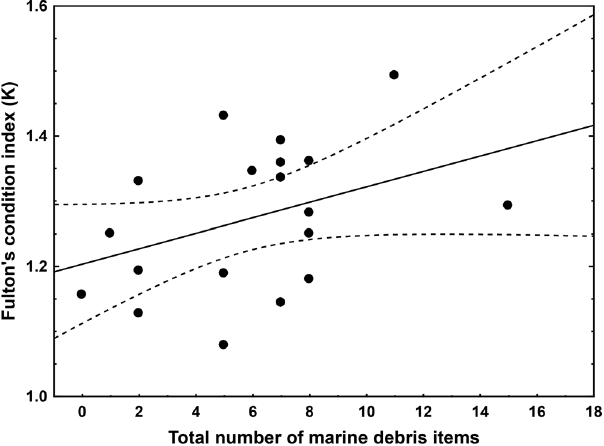
Figure 4. Condition of juvenile coral trout. The condition (Fulton’s condition index, K) of individual juvenile coral trout ( Plectropomus leopardus and P. maculatus ) plotted against the total number of marine microdebris items detected in each of the 20 gastrointestinal tract. Fish were collected on reefs around four reef islands in the Great Barrier Reef World Heritage Area, Australia, in 2011. Linear regression fit and bands (95% confidence level) are presented.